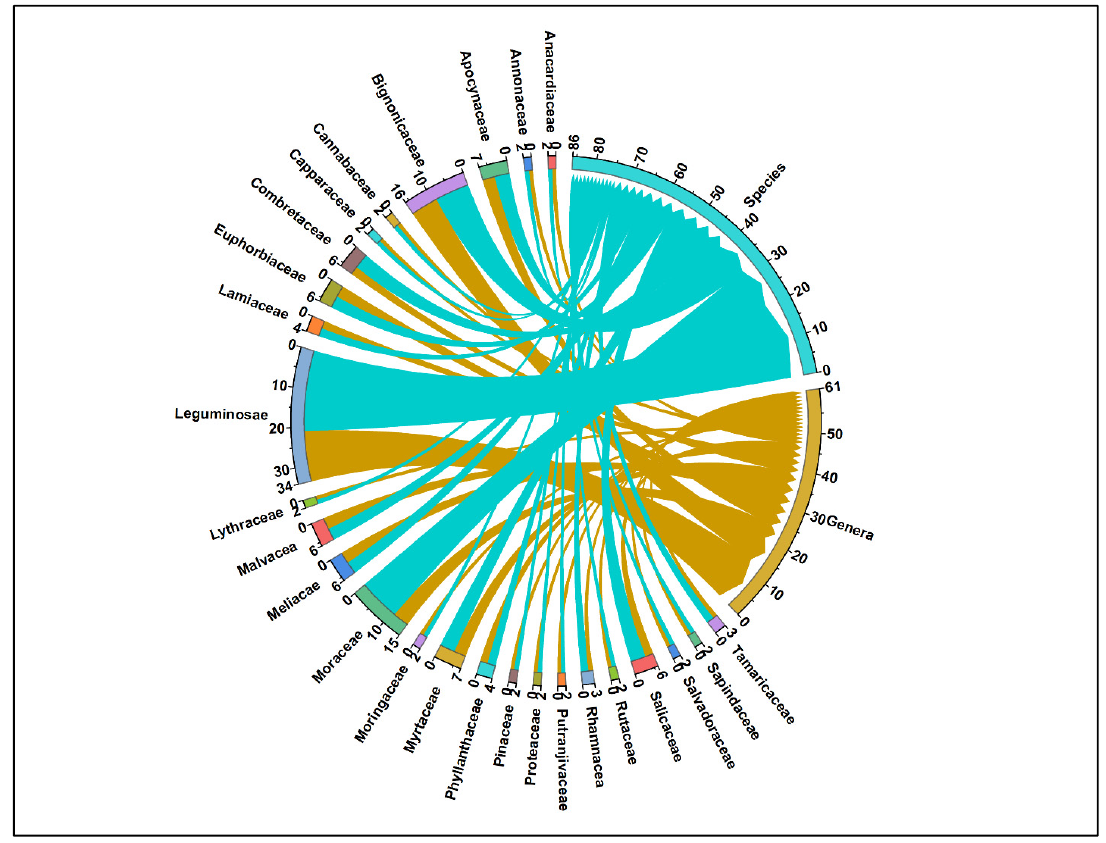
Figure 3. Chord diagram showing the number of species and genera in each family recorded from semi-arid lowland of Punjab, Pakistan.